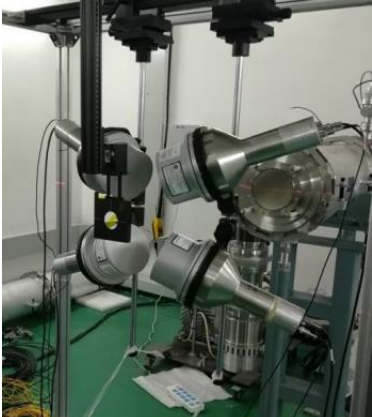
Fig.4. C 6 D 6 detectors are for online experiment